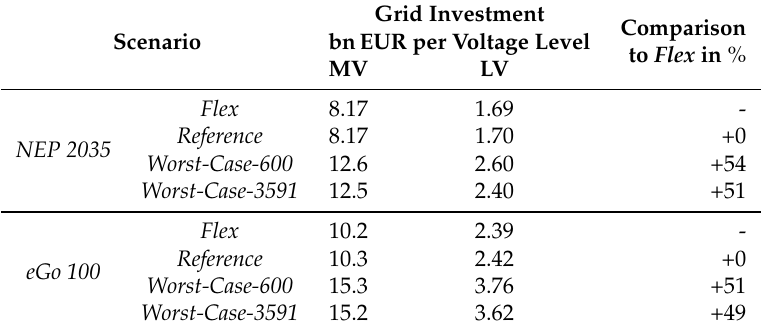
Table 6. Comparison of grid expansion costs per scenario in the MV and LV level based on a calculation of 600 cluster grids. The costs of the transformation levels HV-MV and MV-LV are included in the MV and LV